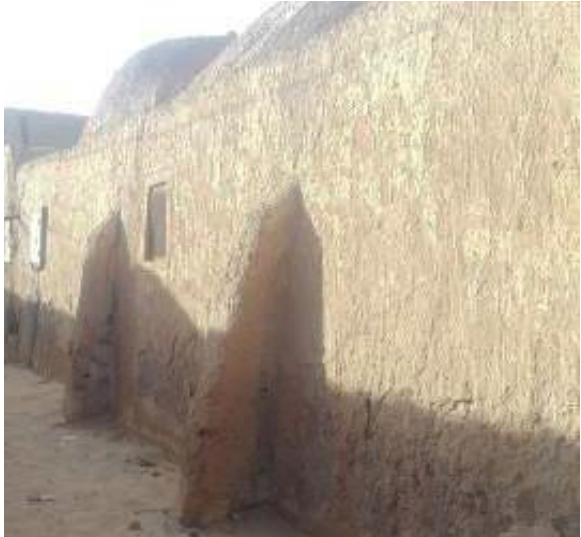
Figure 12. Buttresses of the wall overlooking the